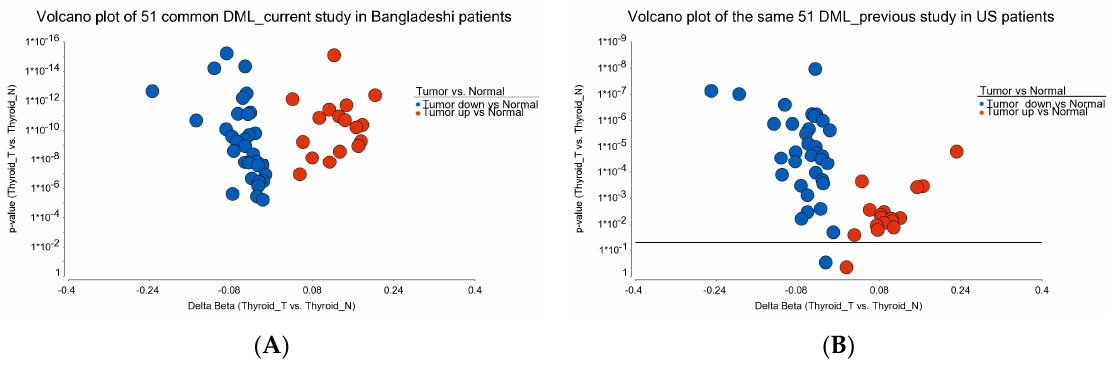
Figure 12. Venn diagram of the 51 common DML found in the current study. The differential methylation of these loci in Bangladeshi patients (current study) is shown on the left ( A ); the differential methylation of these same 51 loci in US patients (previous study) is shown on the right ( B ).